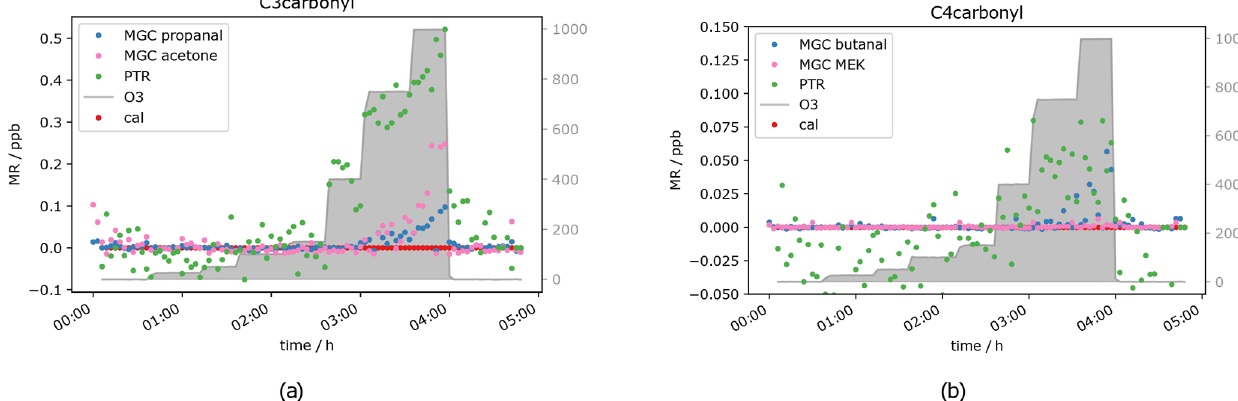
Figure 5. C 3 and C 4 carbonyl mixing ratios of a zero air sample at different ozone